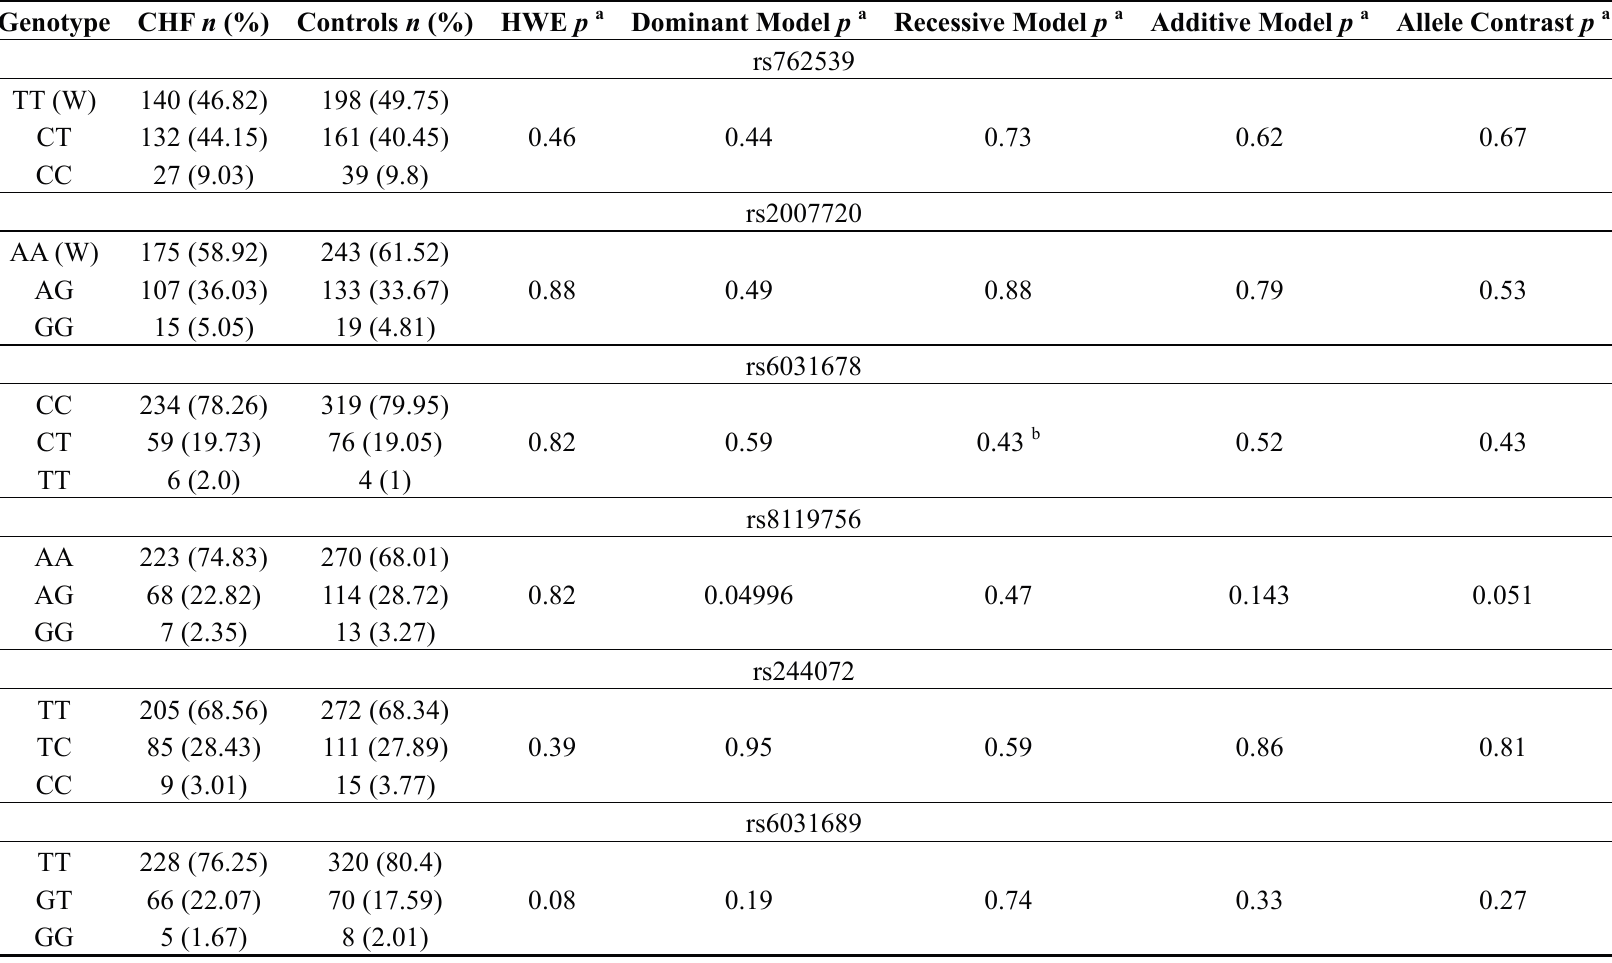
Table 2. Genotype distribution of the eight tag single-nucleotide polymorphisms (SNPs) and their associations with the risk of chronic heart failure under different contrast